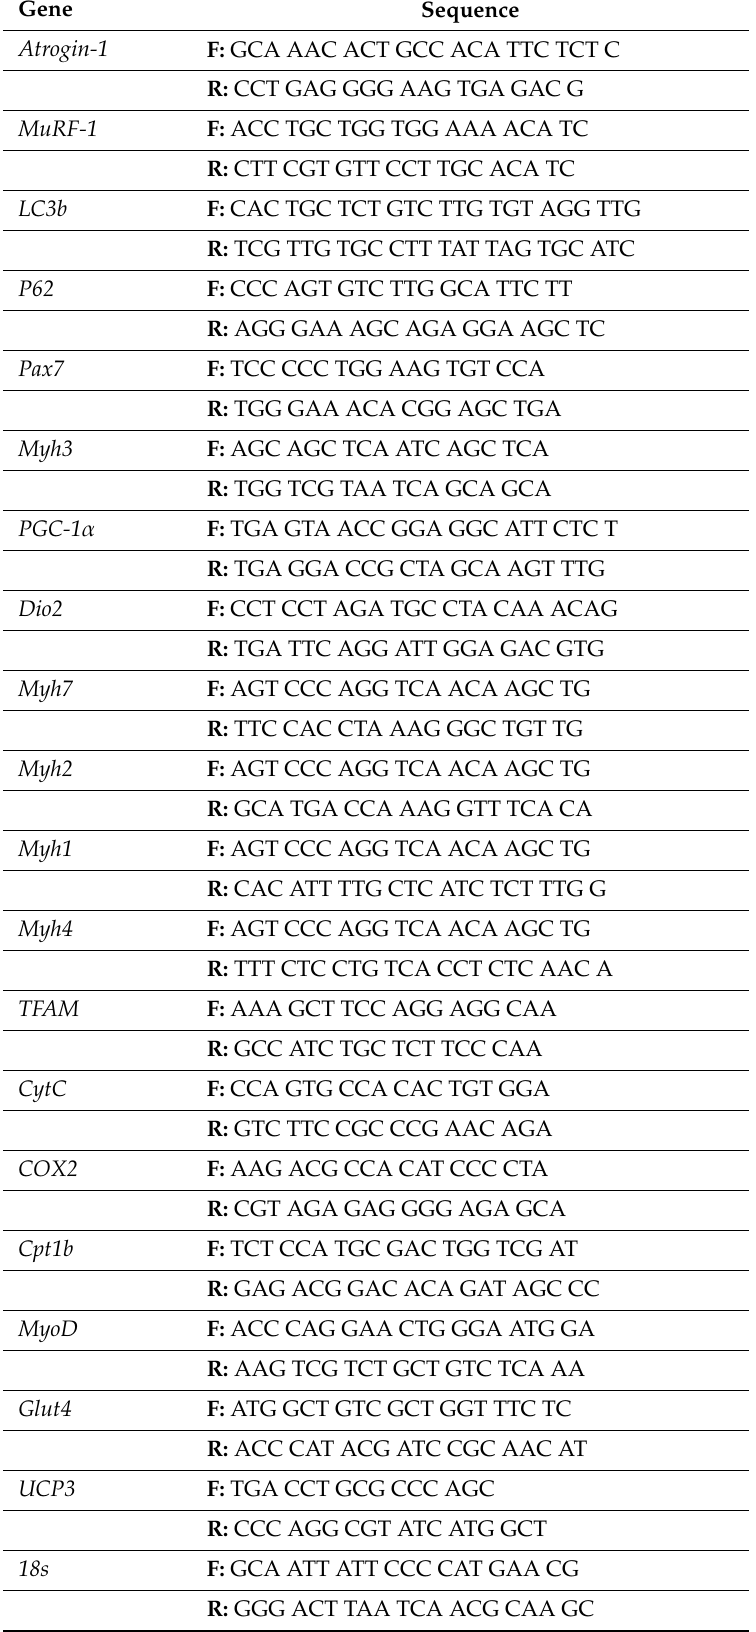
Table 2. Primers used for real-time